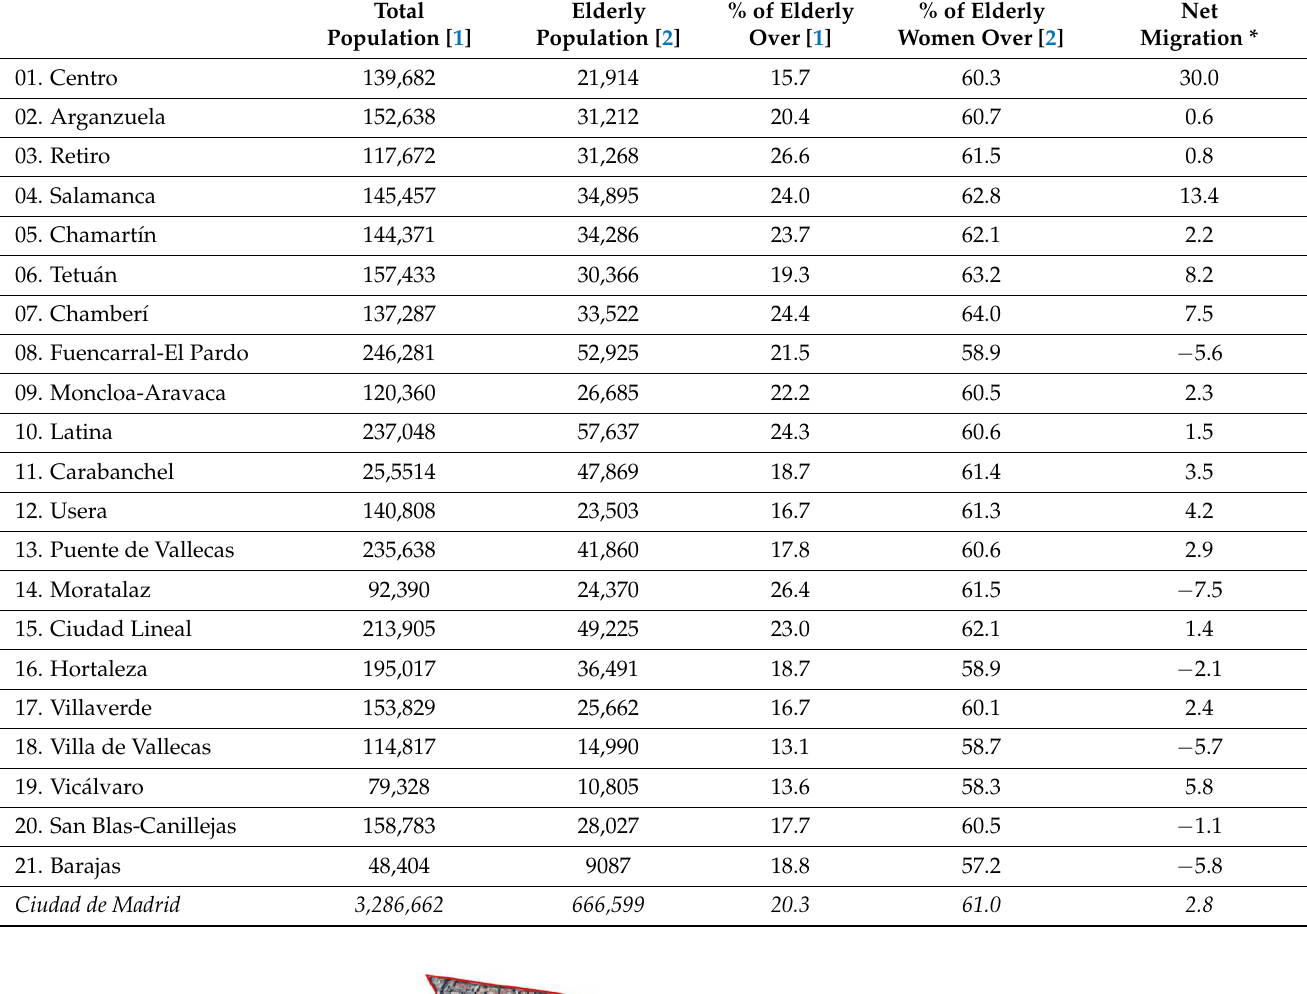
Table 1. * Migration growth in 2020. Rates per 1000 inhabitants. Total population, elderly population, percentage of elderly population over total population, percentage of elderly women over elderly population, net migration, per district, Madrid. Source: Madrid City Council, 2020 and 2022.